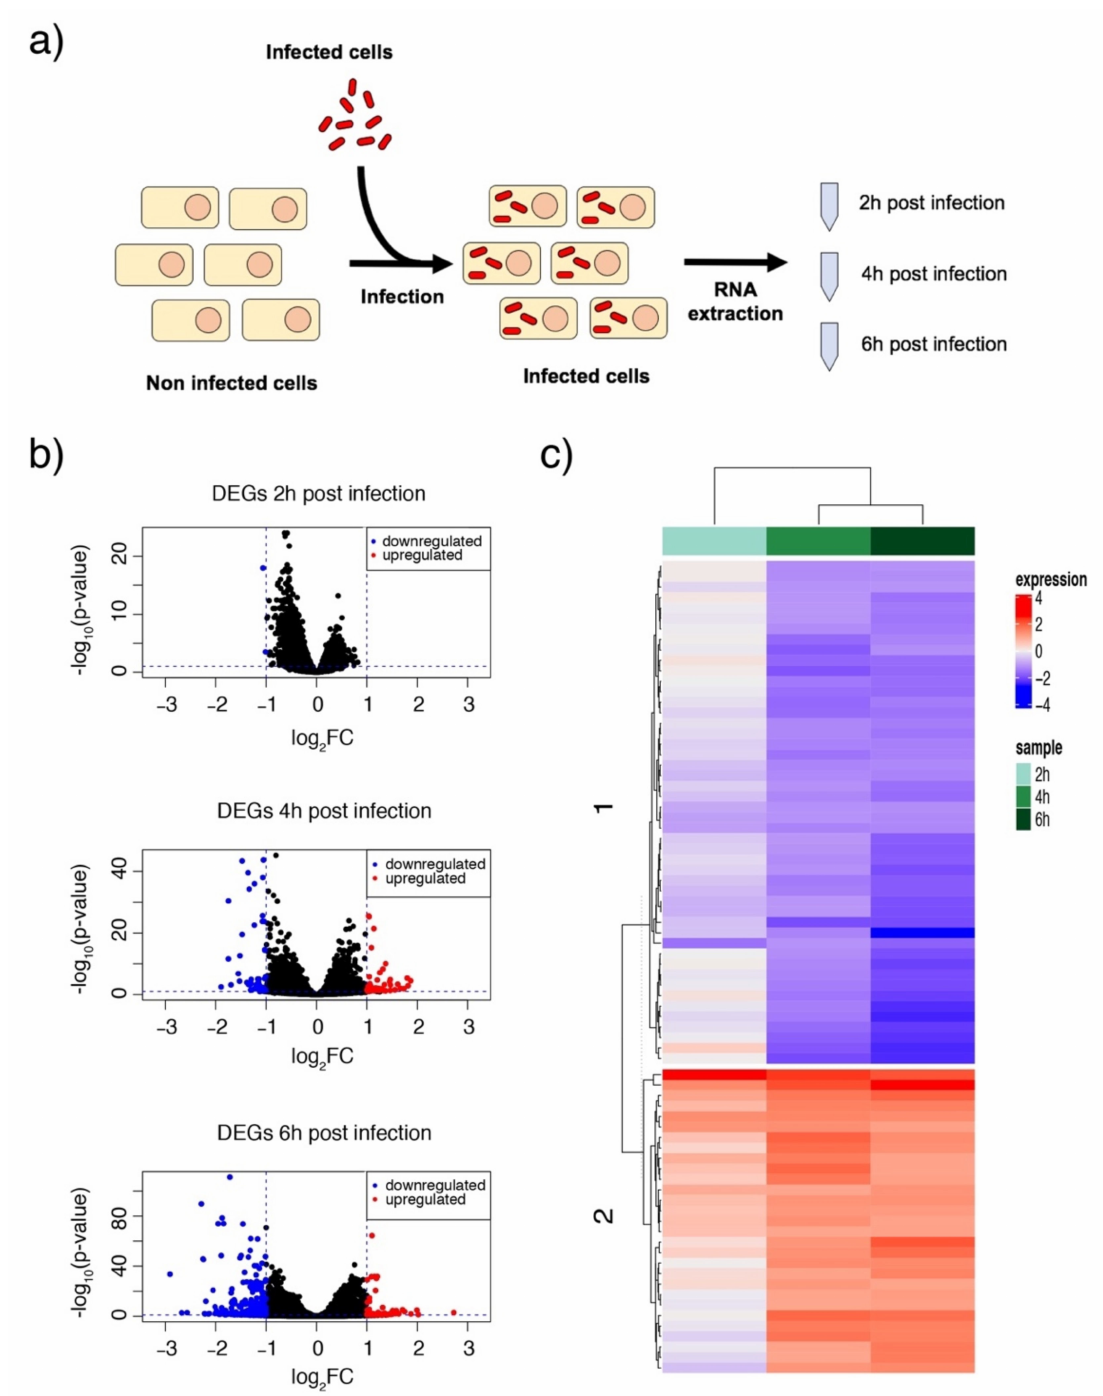
Figure 2. RNA sequencing and analysis of the expression profiles of Differentially Expressed Genes (DEGs). ( a ) HeLa cell infected with A. baumannii at three different infection time-points; RNA extraction was conducted at 2, 4 and 6 h after infection. ( b ) Volcano plots to portray the DEGs. DEGs at 2 h (top), 4 h (middle) and 6 h (bottom) after infection are represented: the X-axis indicates log 2 (FC) and the Y-axis -log 10 ( p -value). The red dots represent upregulated genes ( p -value < 0.05 and log 2 FC < − 1) and the blue dots downregulated genes ( p -value < 0.05 and log 2 FC > 1). This analysis revealed that the changes at 2 h were, globally, not significant compared to the position at 0 h. ( c ) Heatmap showing the relative expression levels for the DEGs (expression type: p -value < 0.05 and log 2 FC < − 2/+ 2). Two main clusters were observed: downregulated genes (blue; cluster 1) and upregulated genes (red; cluster 2). Each column represents the expression level (log 2 fold change) at different time-points: 2 h (light green), 4 h (green) and 6 h (dark